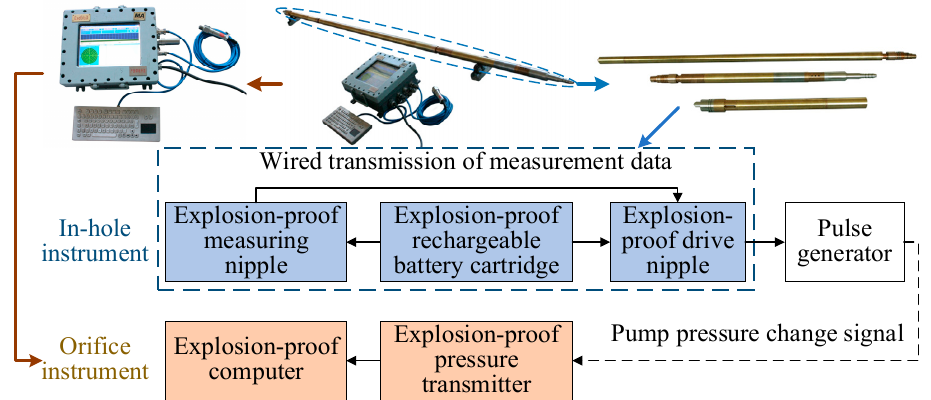
Figure 6. Overall structure composition diagram of mine mud pulse wireless measurement while drilling system.